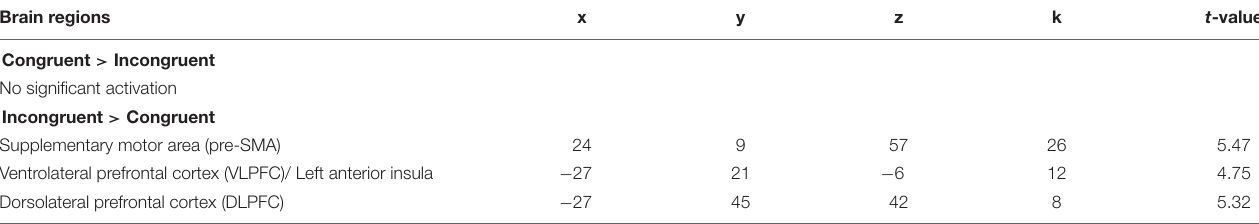
TABLE 2 | Activated brain